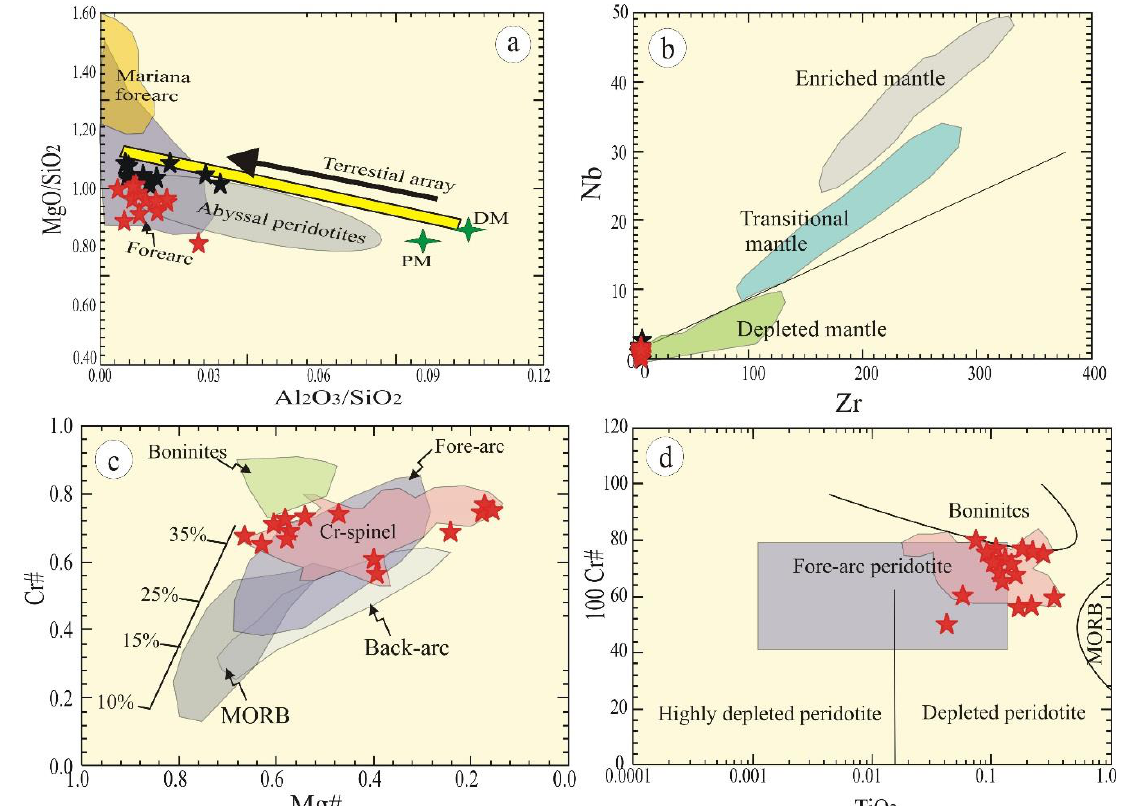
Figure 10. ( a ) Al 2 O 3 /SiO 2 vs. MgO/SiO 2 in the studied ultramafic samples. Abyssal peridotite, primitive mantle, and depleted mantle are from [44,46,67], respectively. Mariana forearc and forearc are from [44,61], respectively. The thick yellow line represents a terrestrial array [71]. ( b ) Zr vs. Nb diagram from [68]; ( c ) Mg# versus Cr# binary diagram from [1]; partial melting degree is from [72]. ( d ) 100Cr# vs. TiO 2 of the examined spinels (Cr- and Al-spinel). Boninites, MORB, forearc peridotites, and depleted and highly depleted peridotites are obtained from [28,73 – 75], respectively. The pink field represents fresh Cr-spinels of the Egyptian Eastern Desert [22].